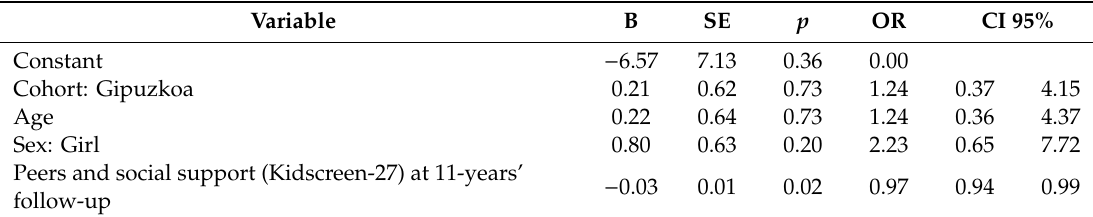
Table 4. Predictors of being a bully for the whole sample.